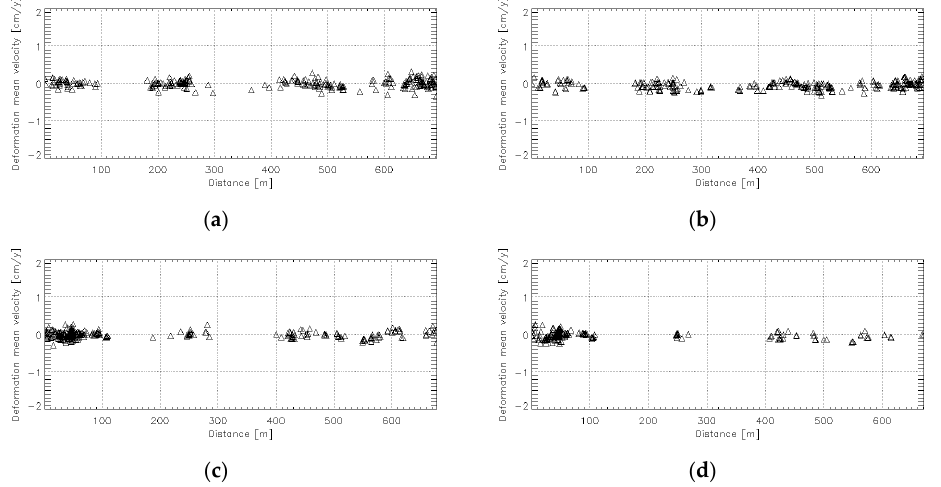
Figure 11. Plots of the estimated mean deformation velocity of the coherent pixels located at the southern roadway level within the red rectangle in Figure 9 for ( a ) SBAS and ( b ) TomoSAR processing results of the ascending dataset, and ( c ) SBAS and ( d ) TomoSAR results relevant to the descending dataset. The horizontal axis corresponds to the longitudinal distance from the origin of the red rectangle located at its southern/eastern end, as reported by the white graduated scale in Figure 9.